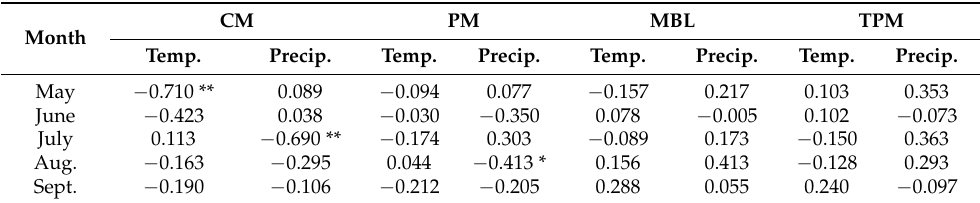
Table 4. The correlation coefficient between the monthly albedo and the temperature/precipitation in the current month (CM), the preceding month (PM), the month before last (MBL), and three previous months (TPM) (statistically significant results are indicated as for a 95% confidence level (*) and 99% confidence level